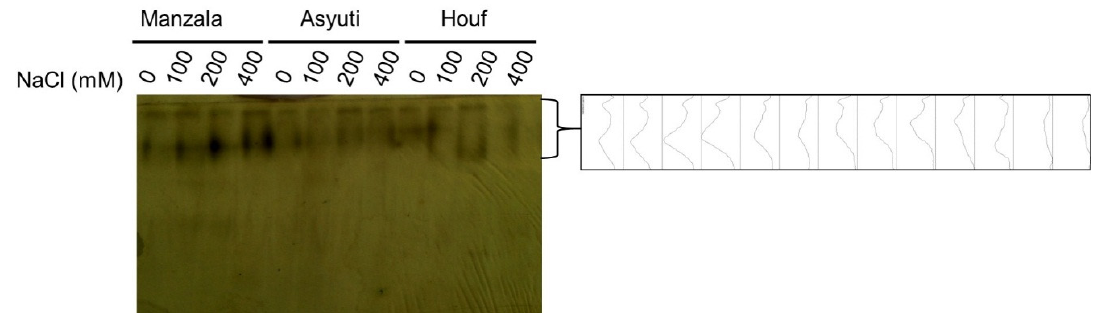
Figure 11. Esterase activity of Z. coccineum plants after 45 days incubation under 0, 100, 200 and 400 mM NaCl.